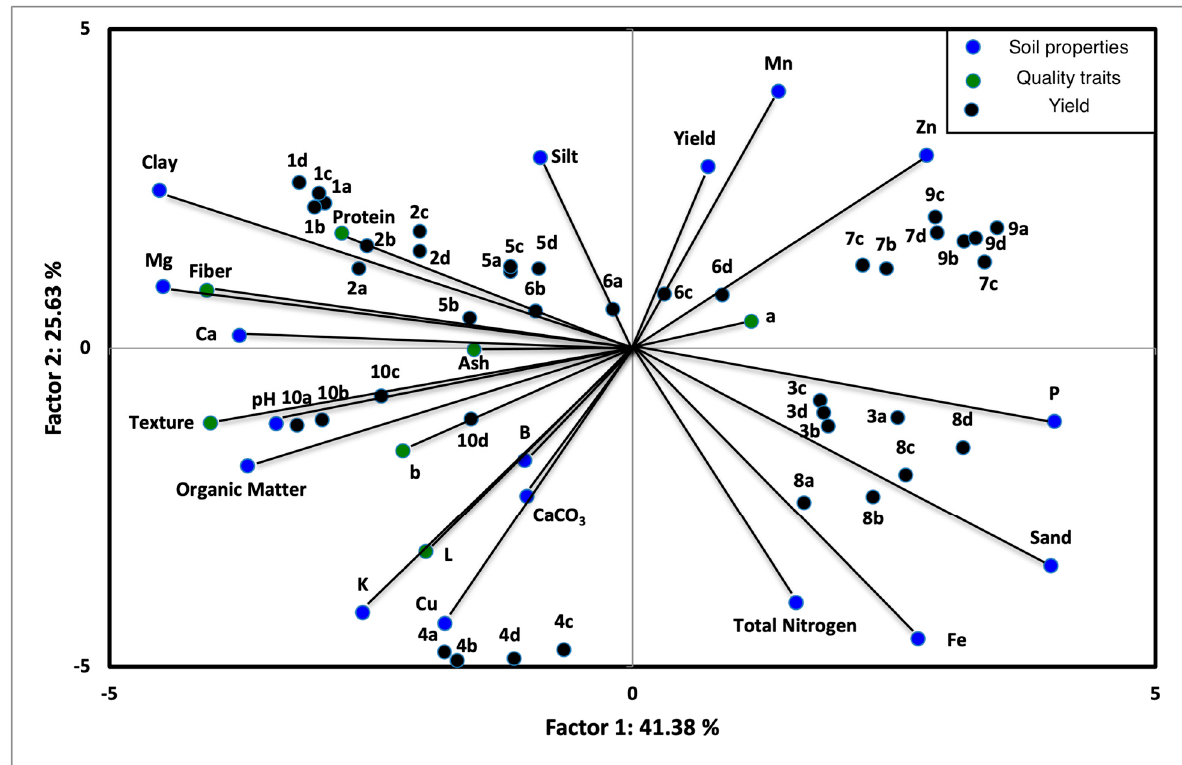
Figure 1. Biplot of principal component analysis of the four different genotypes of maize hybrids at five different environ- mental conditions. Code of different environments of maize hybrids on different genotypes used on principal components analysis (PCA) is listed as follows: Environments: (1) ENV1, (2) ENV2, (3) ENV3, (4) ENV4, (5) ENV5, (6) ENV6, (7) ENV7 (8) ENV8, (9) ENV9 and (10) ENV10 and Genotypes: (a) GEN1, (b) GEN2, (c) GEN3 and (d) GEN4.